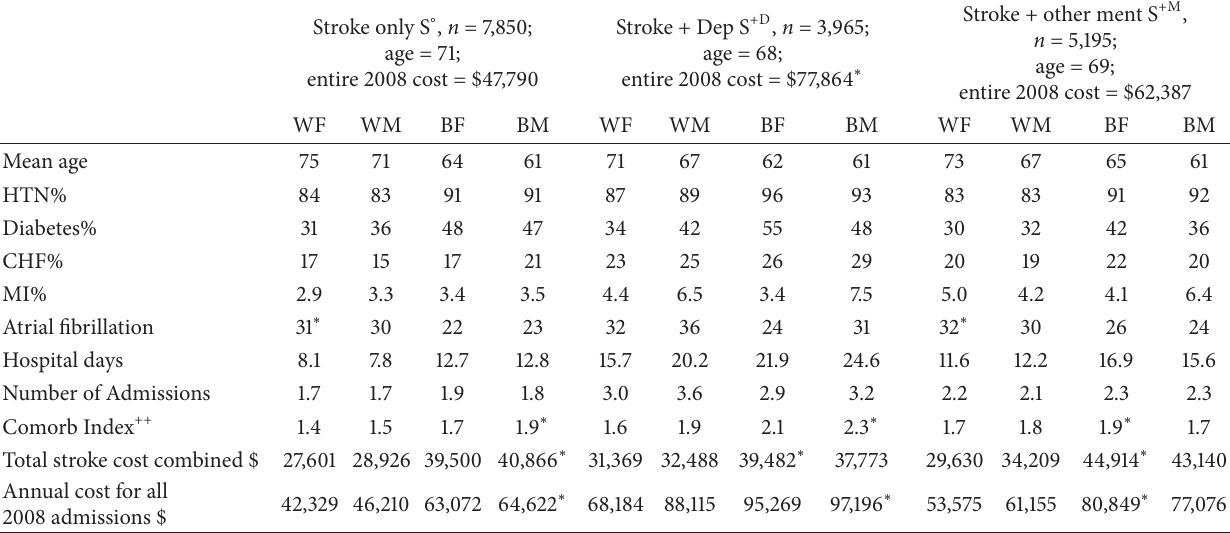
Table 2: Three stroke group cost by race and gender,